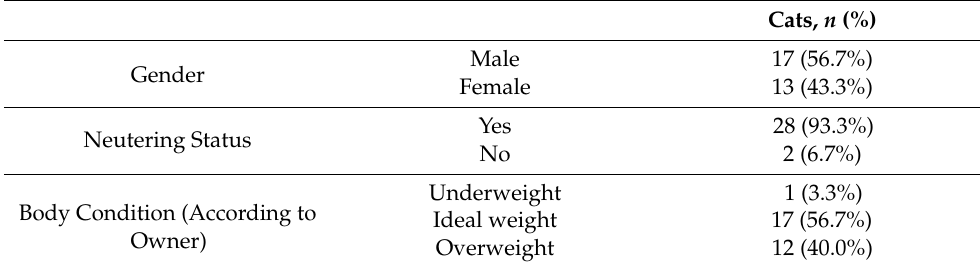
Table 5. Characteristics of cats enrolled in this study ( n =